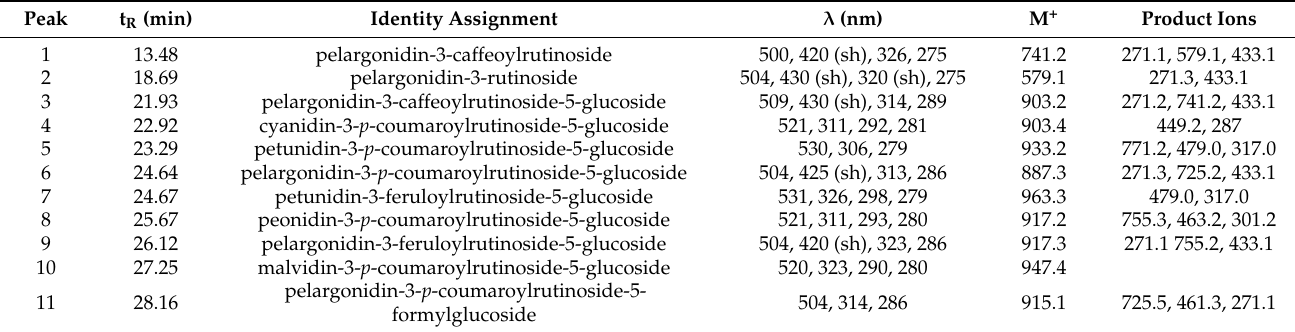
Table 1. Identification of anthocyanins from colored potatoes by a liquid chromatography diode array detector coupled to a mass spectrometer with an electrospray ionization interface (HPLC-DAD-ESI-MS/MS). Peak t R